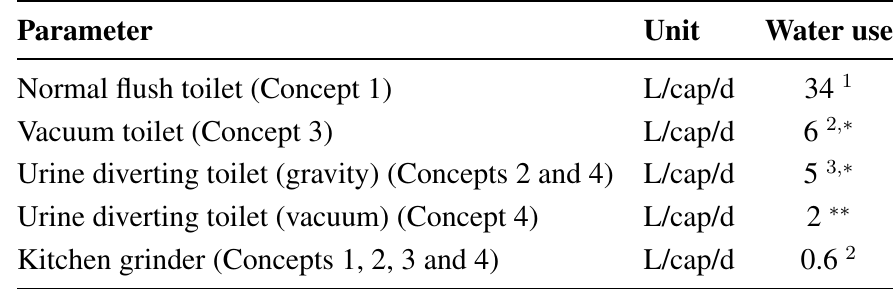
Table 1. Water consumption of different toilets and kitchen